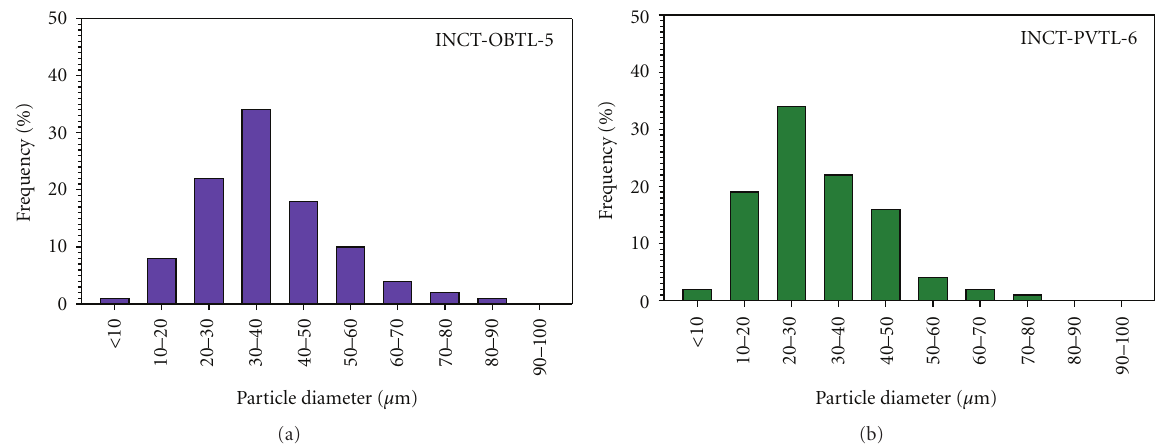
Figure 2: Particle size distribution of the candidate reference materials: Oriental Basma Tobacco Leaves (INCT-OBTL-5) and Polish Virginia Tobacco Leaves (INCT-PVTL-6).